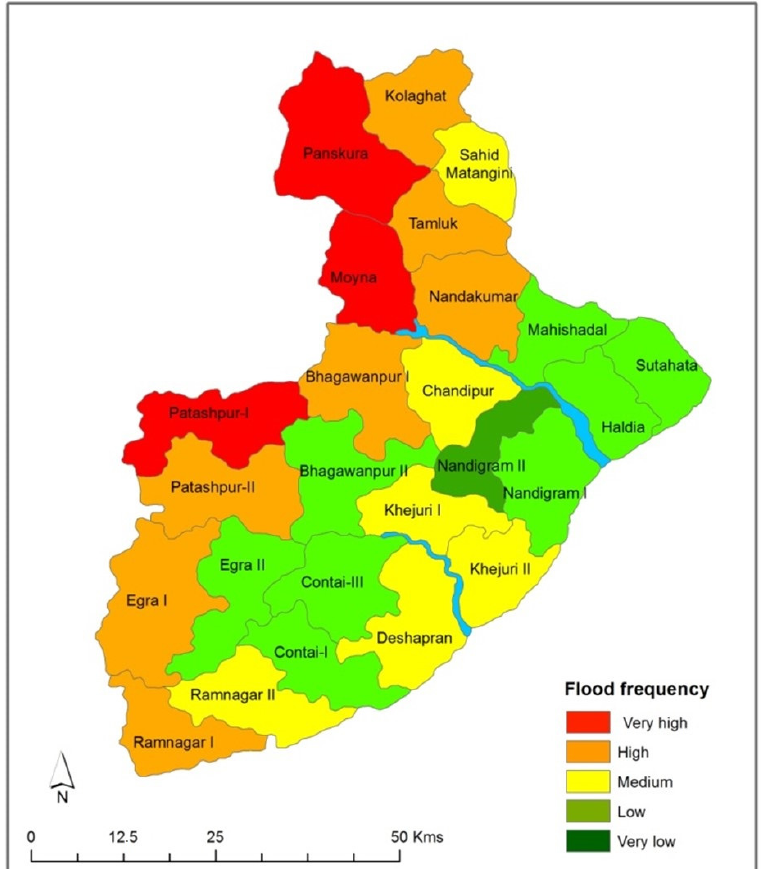
Figure 5. Flood frequency map of Purba Medinipur district (2002–2019).